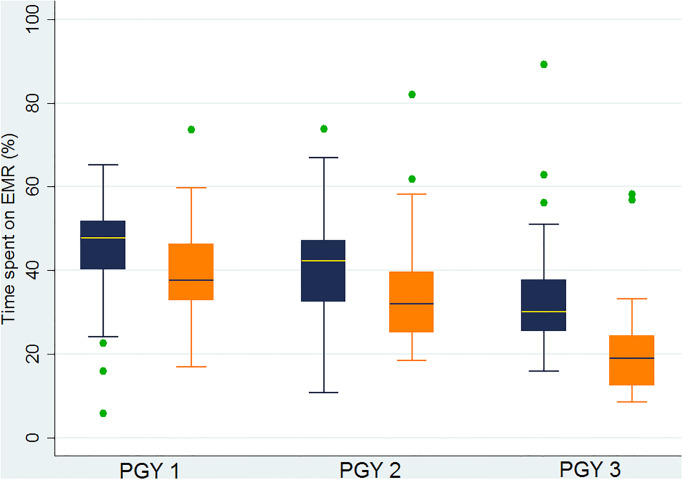
Time spent on EMR daily (%) and resident seniority.Blue—First academic quarter; Orange—Fourth academic quarter.